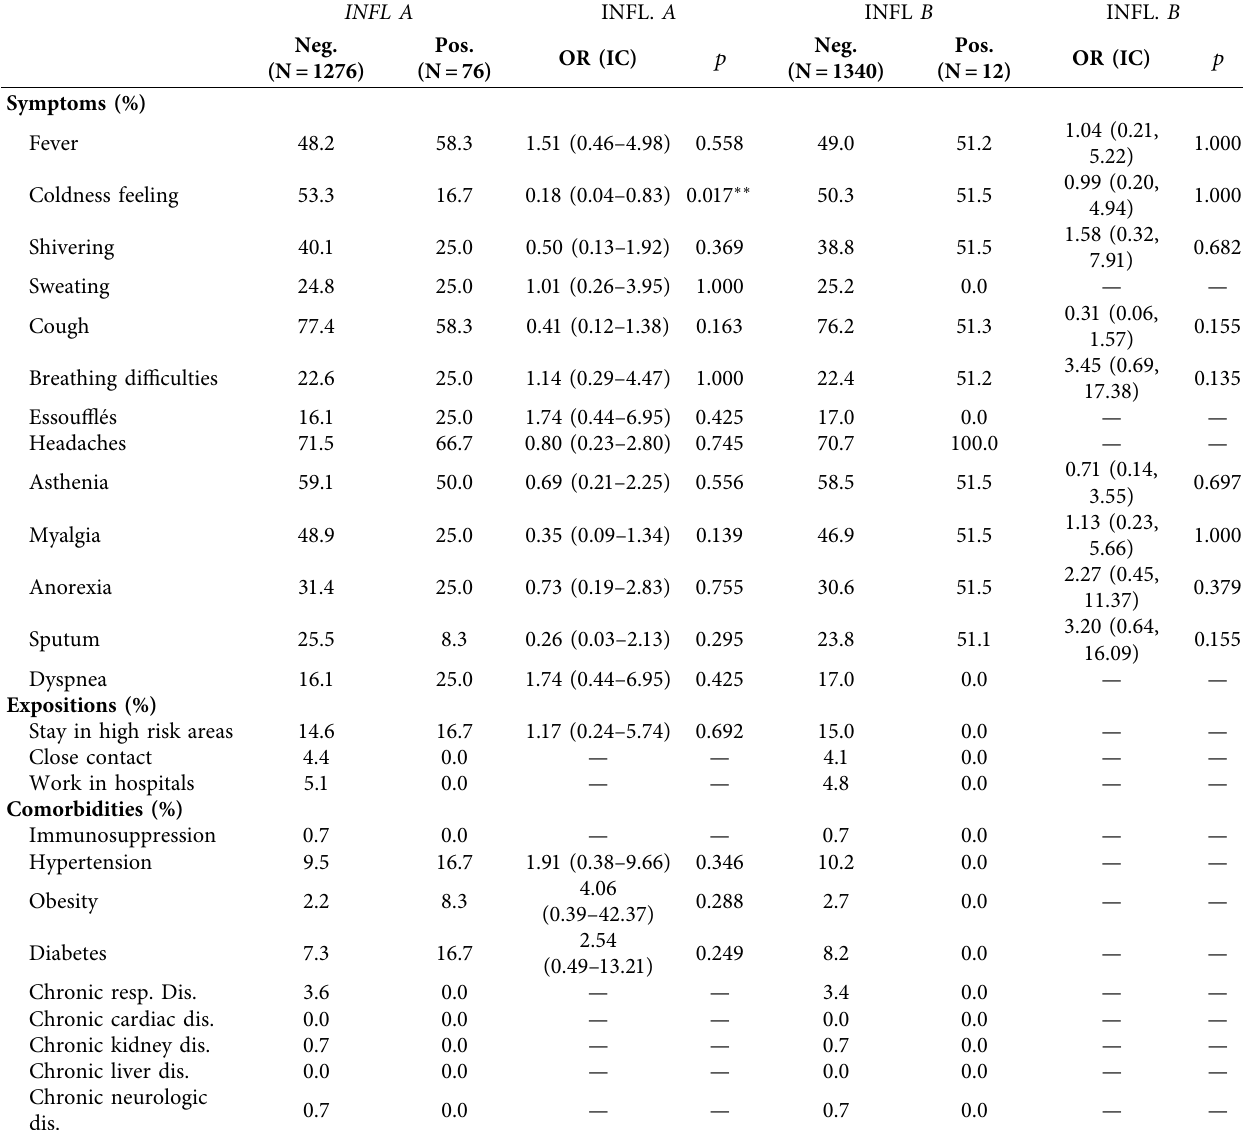
Table 3: Logistic regression analysis regarding demographical gender, exposition, and comorbidity between positive influenza A and B patients.